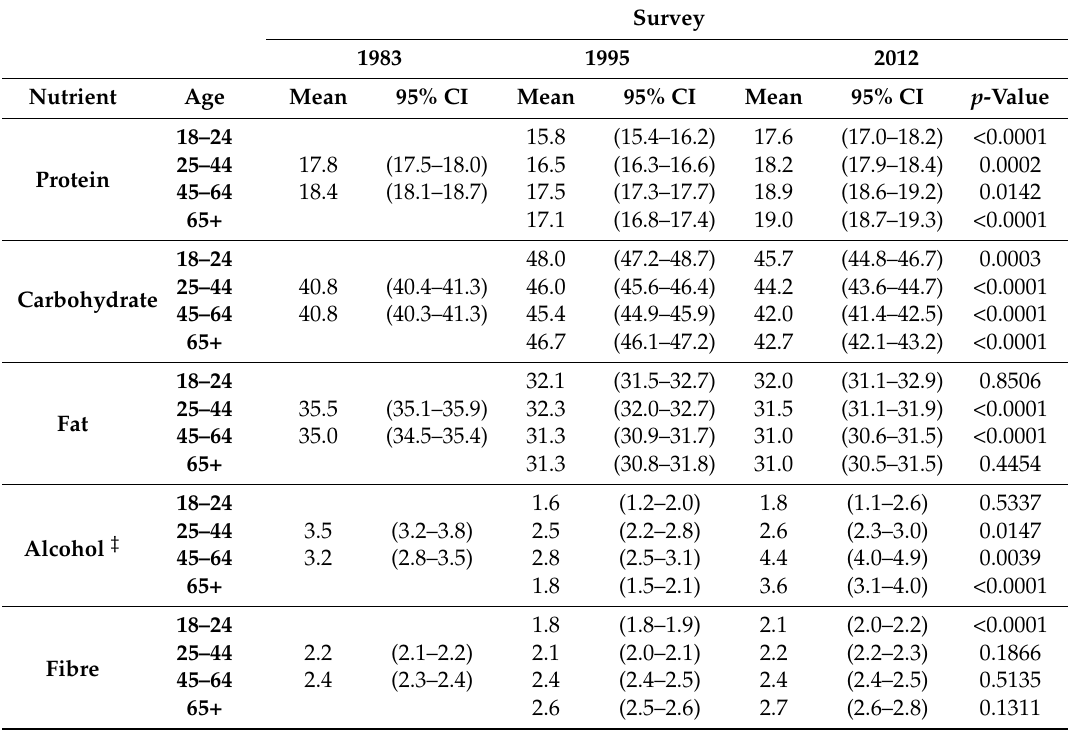
Table 4. Change in percentage energy (%E) from macronutrients for Australian women by age group between 1983 ( n = 3233), 1995 ( n = 5840) and 2012 ( n = 5106) for men from three national nutrition